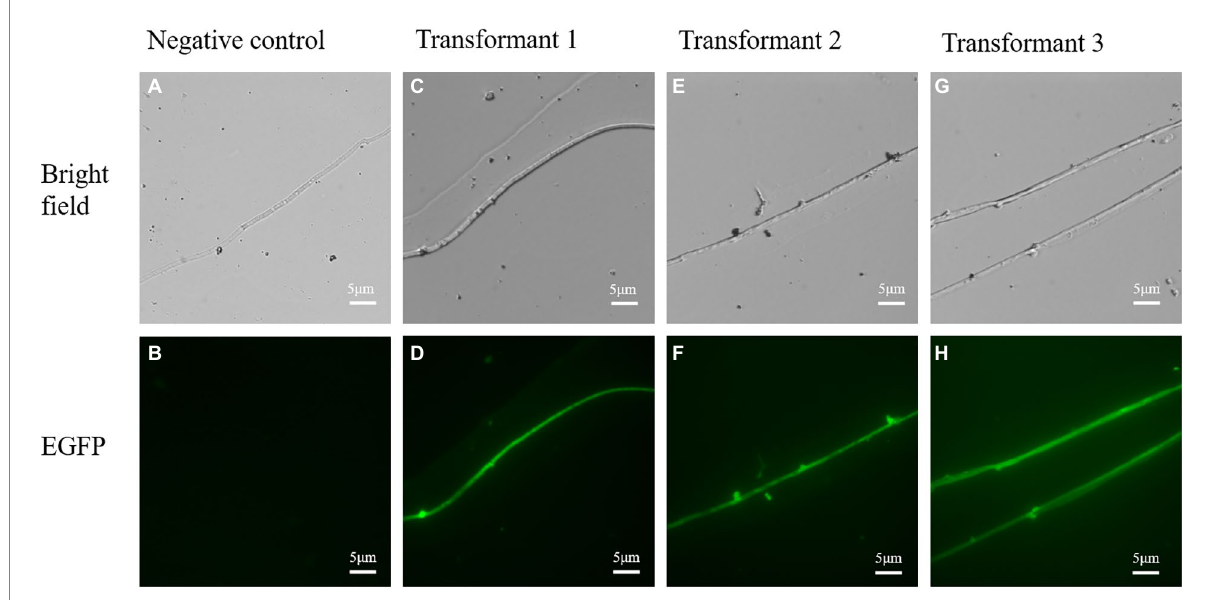
FIGURE 8 The confocal microscopic assays of randomly selected transformants in L. edodes . (A,B) Bright field and green fluorescence images of untransformed mycelia. (C–H) Bright field and green fluorescence images of randomly chosen transformed mycelia.